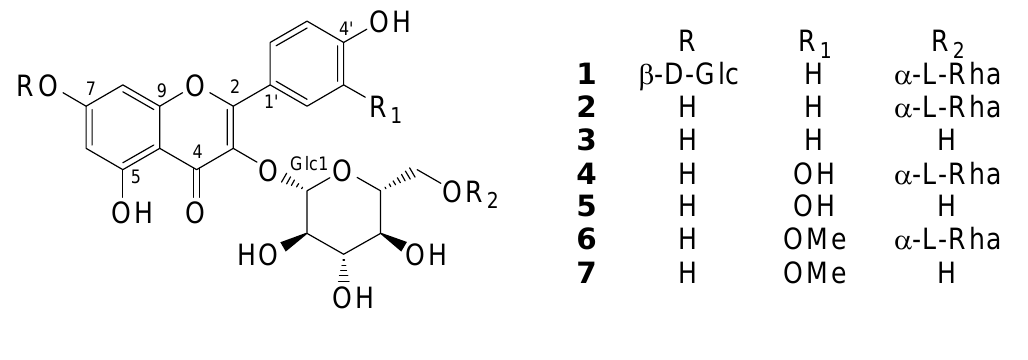
Figure 1 . Flavone glycosides from M.